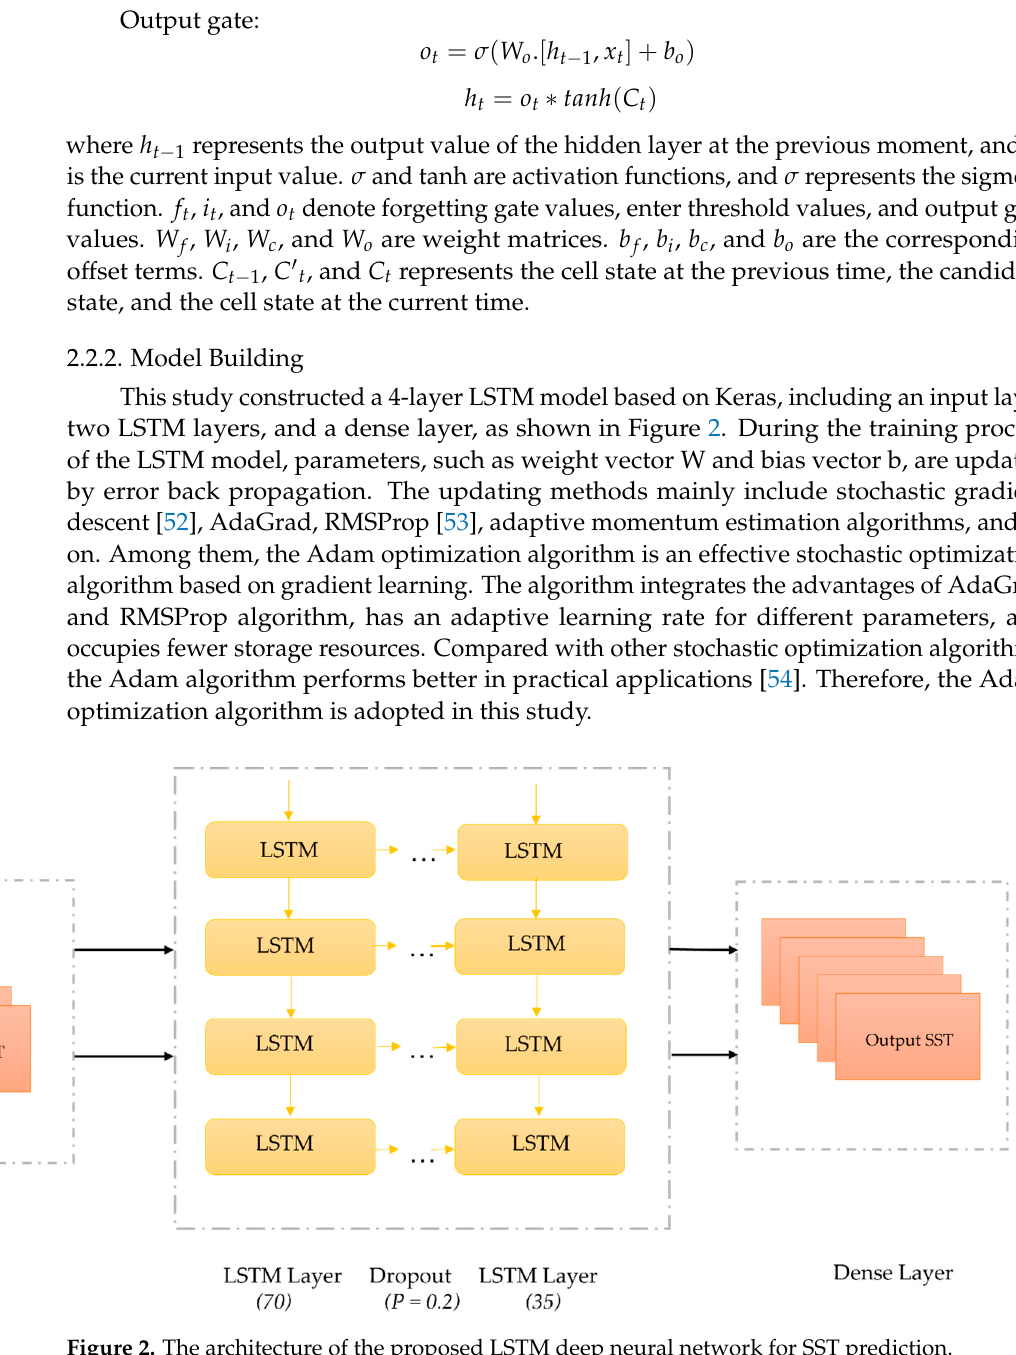
Figure 1. Structure of long short-term memory (LSTM) memory cell, including the forget, input, and output gates.